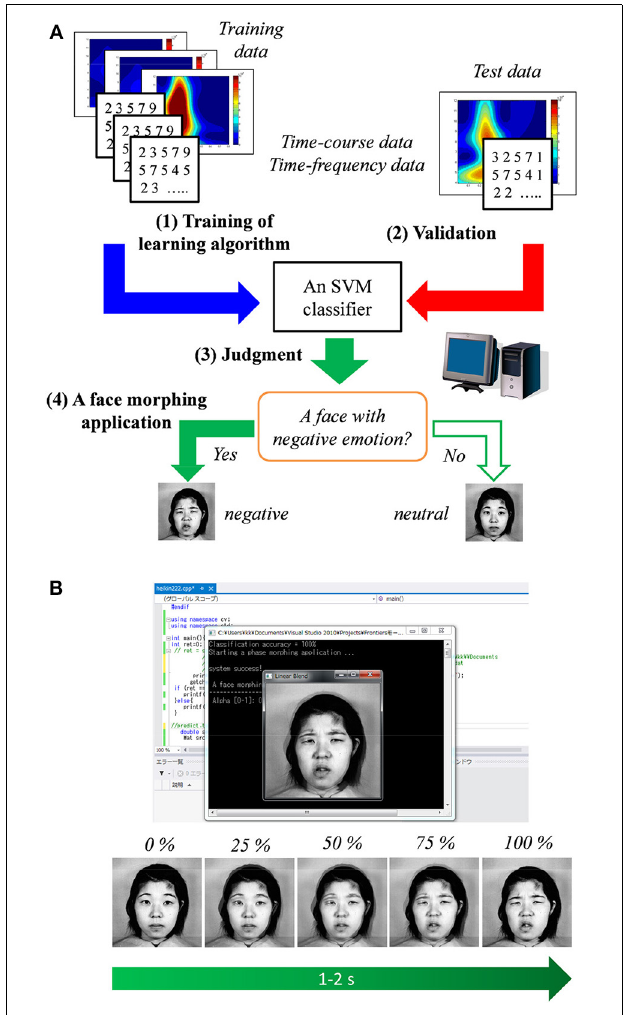
FIGURE 5 | (A) Diagram of the proposed method in which a support vector machine (SVM) classifier is used. (B) Illustration of the face morphing software triggered by the classifier’s